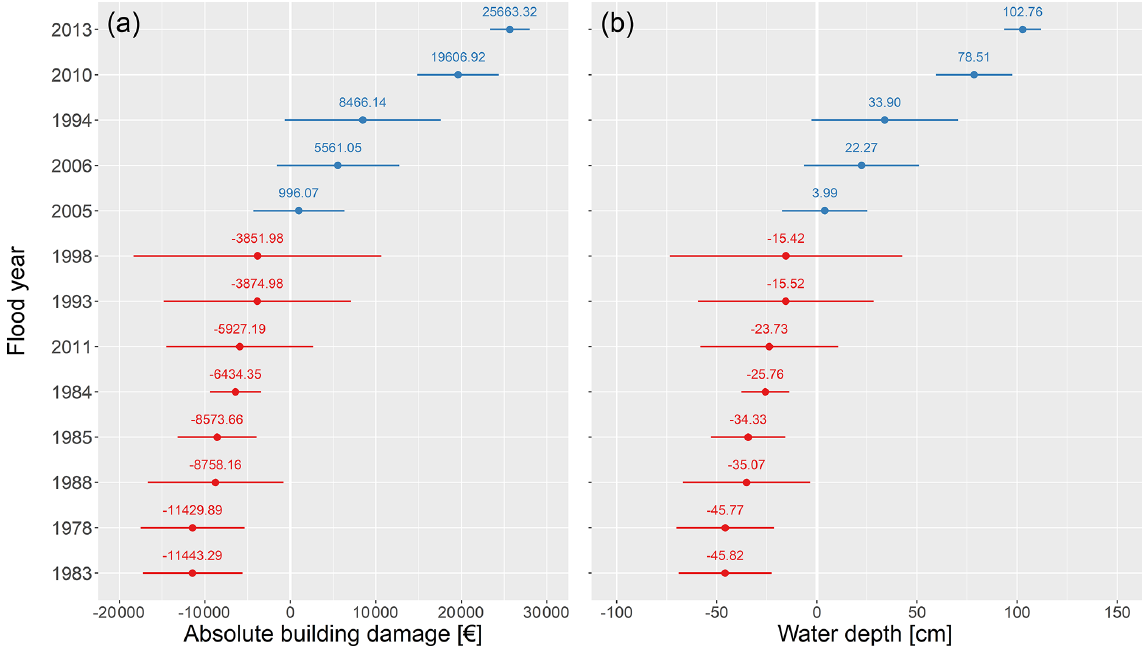
Figure 6. Dot-and-whisker plot of group effects of the multilevel linear regression model for absolute damage to buildings in the private household sector. The plot (a) corresponds to the random intercept, i.e. the variation in the intercept per group from the overall intercept of a simple linear regression. Each group represents a particular flood year. The plot (b) depicts the random slopes. The plotted values are the mean differences between the intercept for each group and the overall intercept (or slope for each group and the overall slope). The whiskers correspond to the range of group-specific residual